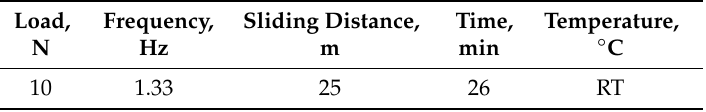
Table 5. Tribological test conditions.